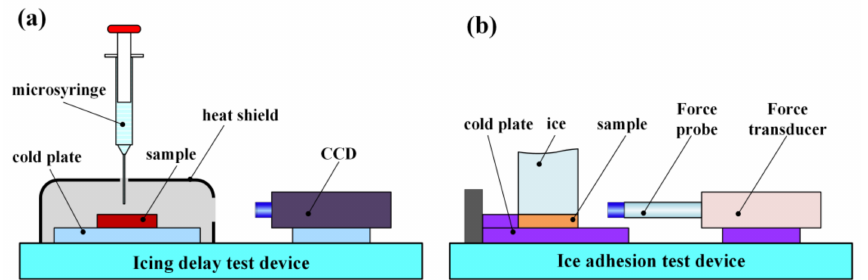
Figure 4. Schematic diagram of experimental device. ( a ) Icing delay test device; ( b ) icing adhesion test